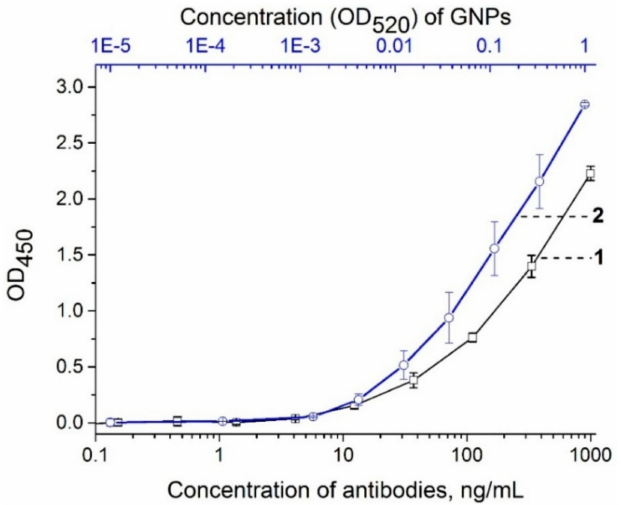
Figure 4. Enzyme-linked immunosorbent assay (ELISA) testing of the binding between immobilized PVY N and anti-PVY antibody (curve 1), and GNP–anti-PVY antibody conjugate (curve